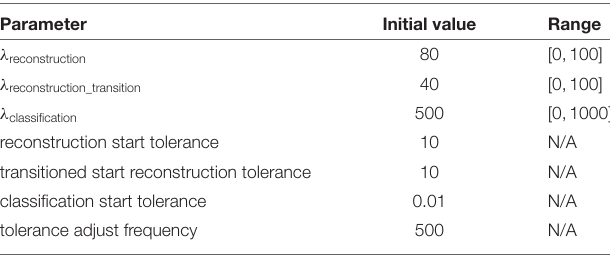
TABLE 2 | Values used in the constrained optimization mechanism (Rezende and Viola, 2018), used for training a